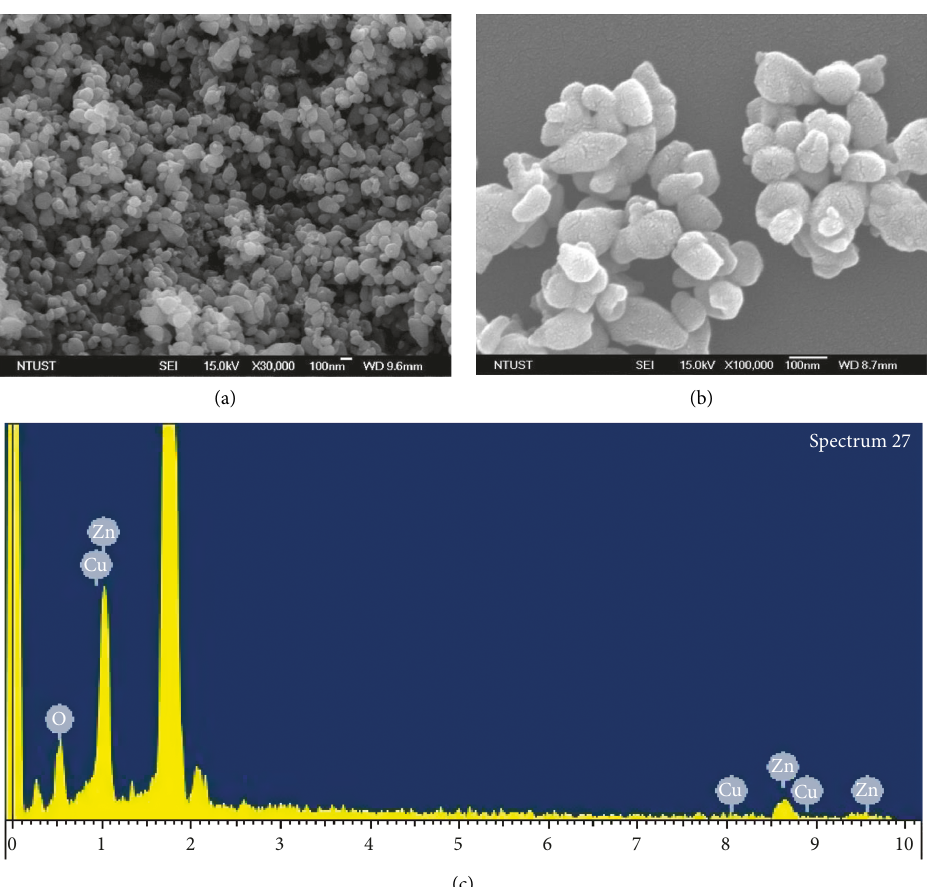
Figure 2: (a-b) SEM image of lower and higher magnifications, and (c) the EDS analysis for Cu-ZnO (3%) with plant